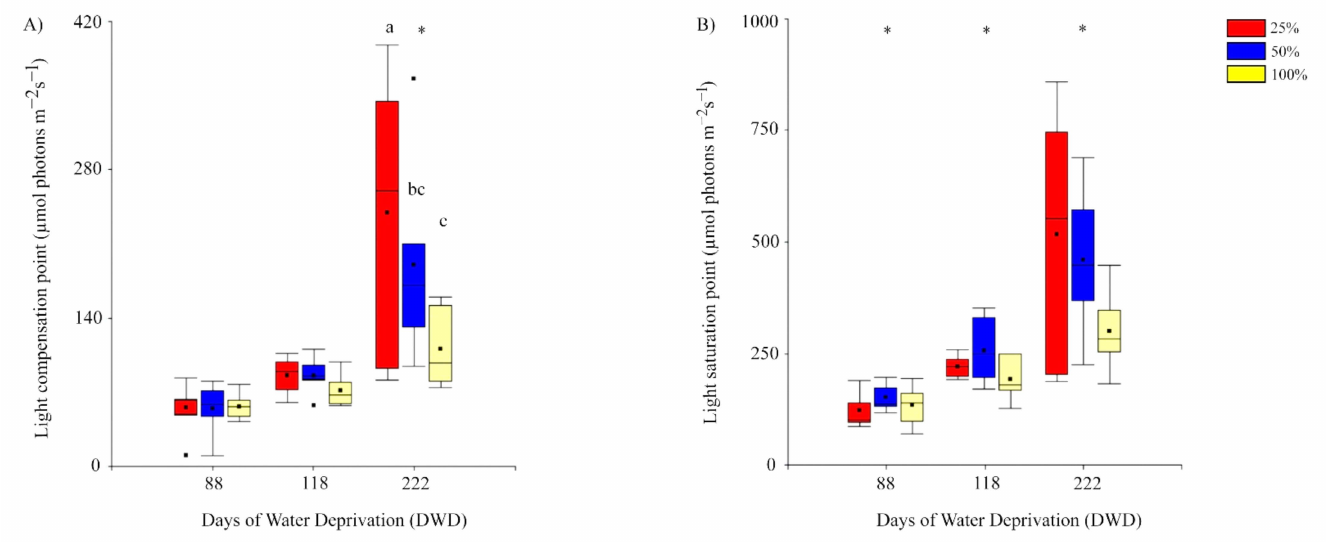
Figure 5. Box plots showing the changes of ( A ) light compensation and ( B ) light saturation points during the experiment of water deprivation (DWD). Lines, dots, and colors of each box correspond to what was previously indicated in Figure 2. Asterisk indicates significant differences between DWD at p ≤ 0.05. Different letters indicate significant differences ( p ≤ 0.05) between preconditioning treatments within a given period of water